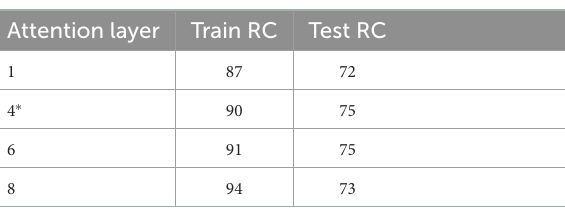
TABLE 3 Attention layer test. TABLE 4 Impact of sampling rate on the dual-flow